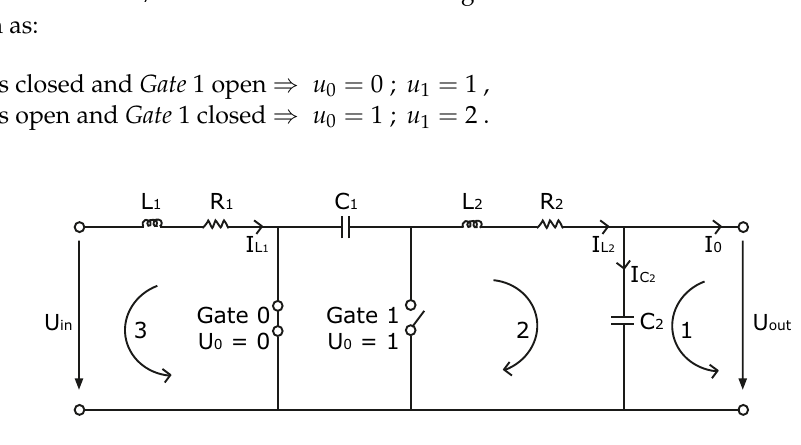
Figure 8. Circuit diagram of the DC/DC